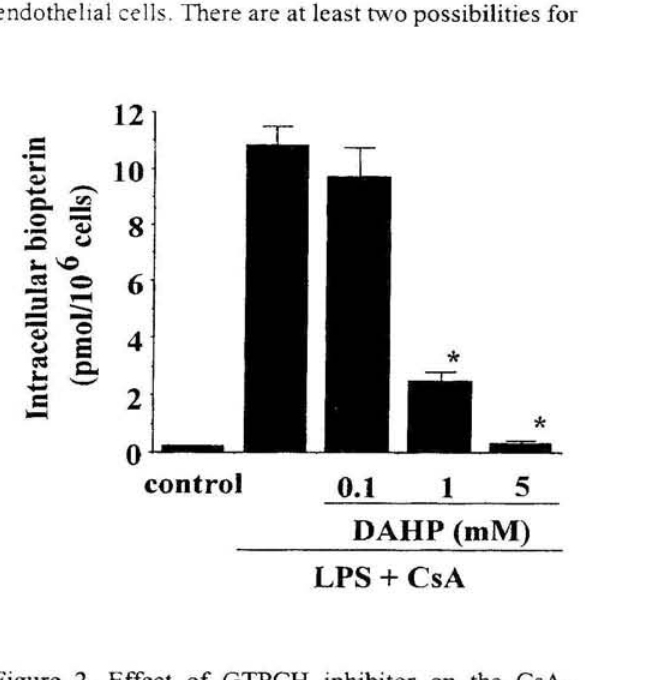
Figure 2. Effect of GTPCH inhibitor on the CsA- induced increase in BH4 content during LPS treatment. The cells were incubated with CsA (10 μΜ) plus LPS (100 ng/ml) in the presence of various concentrations of DAHP (0-5 mM) for 12 h. Values are the means ± S.E.M. of 4 experiments. * Significantly different from the CsA plus LPS group